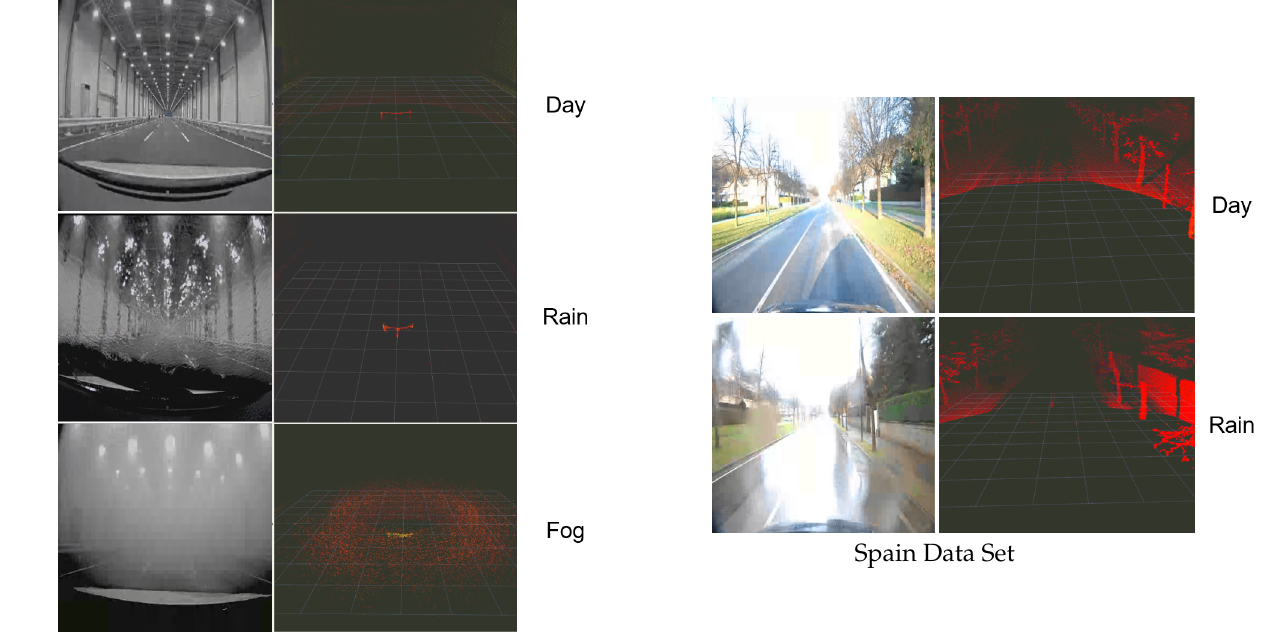
Figure 4. Examples of the JARI and Spain data sets. The JARI data were collected using an Ouster-64, while the Spain data were obtained by an Ouster-128. Thus, the data sets are slightly different. However, we designed the respective architectures separately. Furthermore, fog data do not exist in the Spain data set, due to the climatic characteristics of